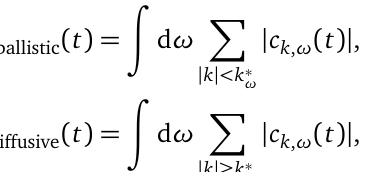
Figure 10: Left panel: the decay of different momenta modes δ n line corresponds to non-diffusive hydrodynamics. Right panel: The time dependence of the variance of the position. In the linear regime we fit the diffusion coefficient according to (26). At late time the turn over of the variance is caused by the periodic boundary conditions.